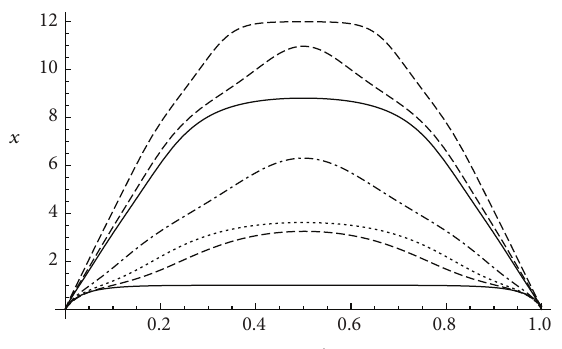
Figure 18: Seven solutions of problem (15), (10), 𝛼 ≈ 31.5093 , 𝛼 ≈ 31.6248 , 𝛼 ≈ 32.3915 , 𝛼 ≈ 34.6074 , 𝛼 ≈ 43.6897 , 𝛼 ≈ 45.7099 , and 𝛼 ≈ 51.0893 .